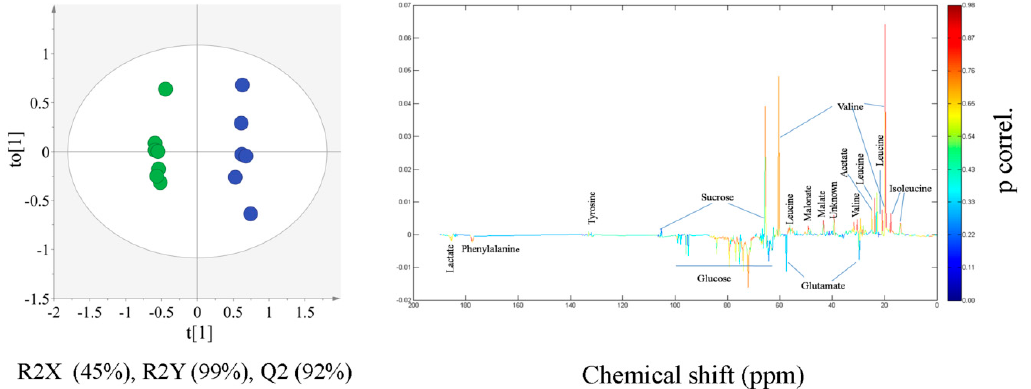
Figure 3. OPLS-DA score scatter plot derived from 13 C-NMR spectra of Chinese red cooking (green circle) and Japanese shoyu (blue circle) soy sauce and the color-coded loading line plot generated from the OPLS-DA model representing the metabolites responsible for discrimination among Chinese red cooking and Japanese shoyu soy sauce.